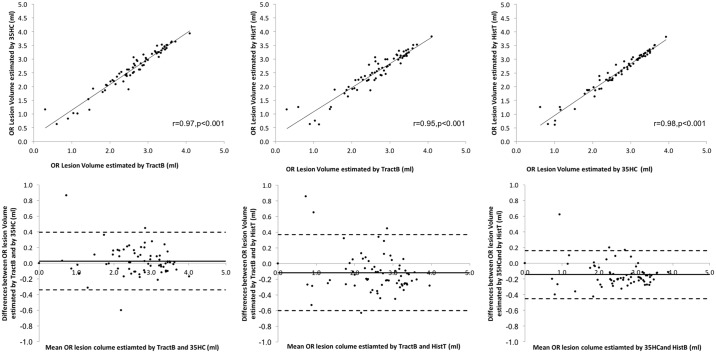
Comparison of OR lesion volume estimated by PT-OR, Template-OR and Histology-OR.The total lesion volume is shown as logarithmic values.